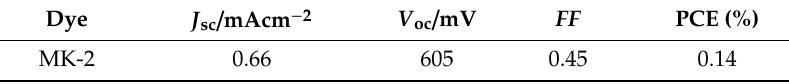
Figure 2. ( a ) Current–density versus voltage ( J–V ) curve measured by illuminating a 0.2 cm 2 area of the MK-2-DSSC prepared for LSM under AM 1.5G irradiation (100 mWcm − 2 ). ( b ) Corrected photocurrent ( I cor ) obtained by subtracting dark current from photocurrent measured under short-circuit condition. Note that the plot of I cor was obtained at the submicrometric laser illumination (~10 − 9 cm 2 ) using LSM. The red dashed line indicates the saturation value of I cor . Table 1. Photovoltaic parameters, short-circuit current density ( J SC ), open-circuit voltage ( V OC ), fill factor ( FF ), and photoconversion efficiency (PCE), of the MK-2-DSSC fabricated for laser scanning microscopy.